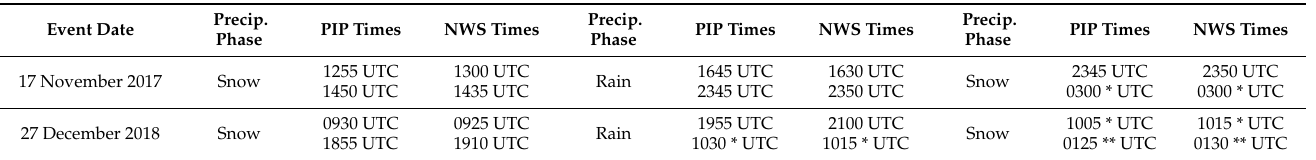
Table 2. Events with a multiple precipitation phase transitions with observations from the PIP and the NWS MQT forecaster records. * Denotes +1 day and ** denotes +2 UTC from start date.